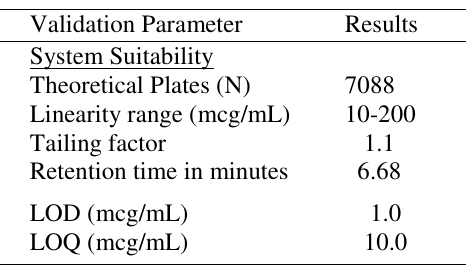
Table 3. Validation